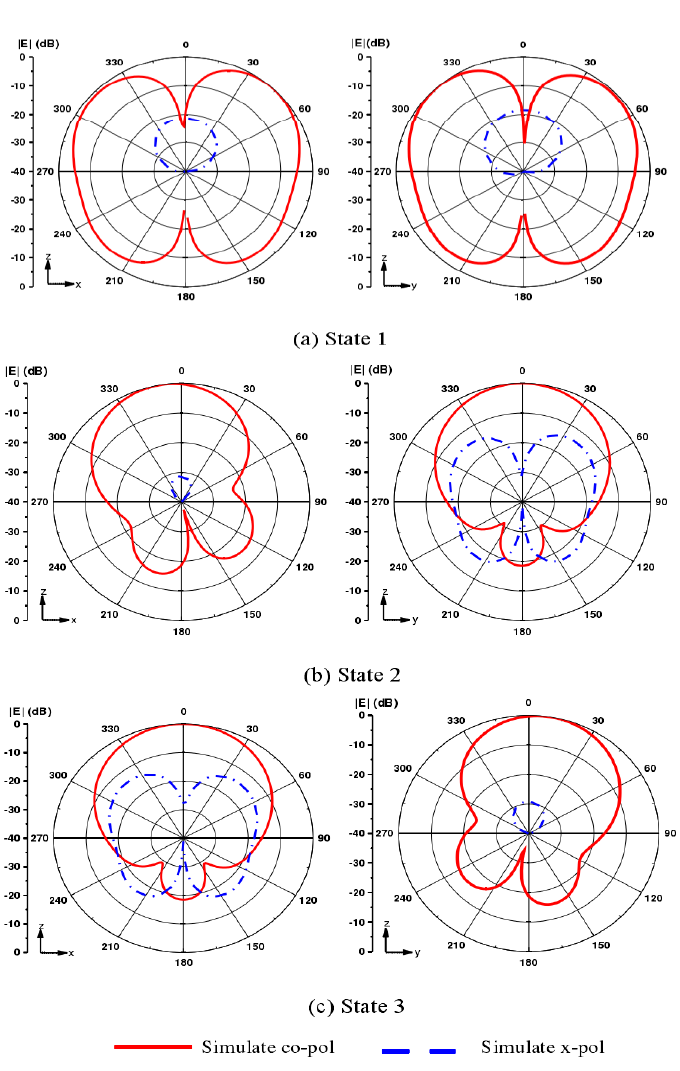
Figure 3. Radiation pattern in ( a ) working state 1, ( b ) working state 2, ( c ) working state 3.